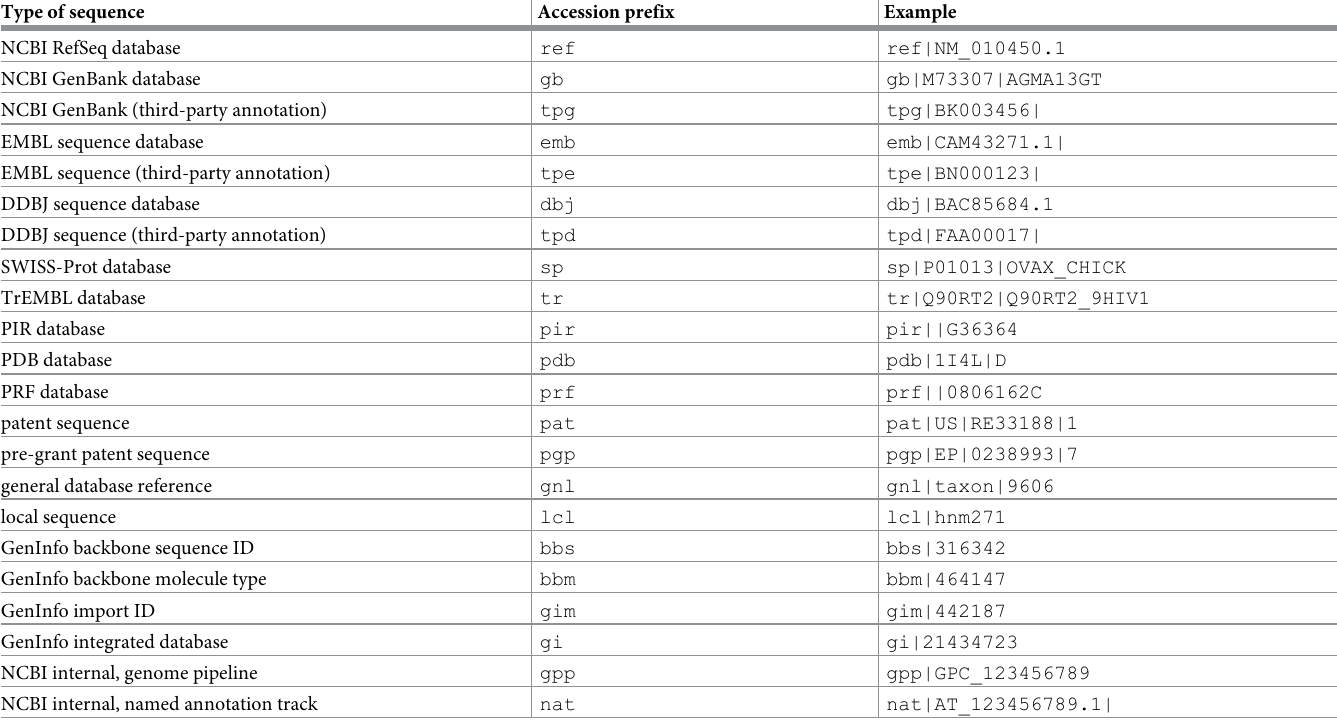
Table 6. Fasta sequence identifiers used by NCBI, defined in the spec/ncbi_id.yaml TextFormats